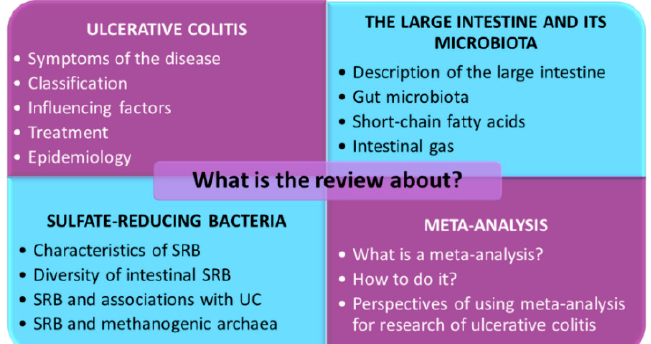
Figure 1. The main points of the review. SRB: Sulfate-Reducing Bacteria; UC: Ulcerative Colitis.